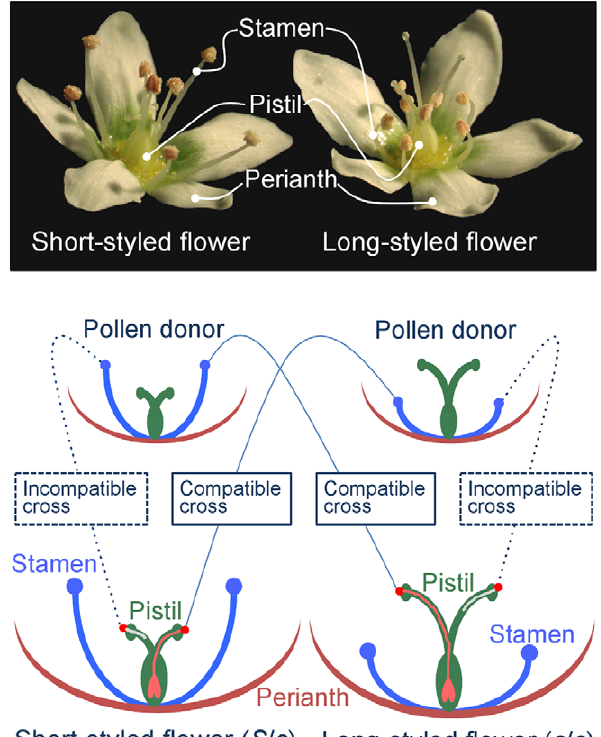
Figure 1. Dimorphic flowers of buckwheat and schematic presentation of the intra-morph incompatibility response in buckwheat. Short-styled flowers of buckwheat have long stamens and vice versa. A pollen grain from a long-styled plant germinates and the pollen tube successfully elongates to reach the ovary in the pistil of a short-styled plant, whereas it germinates but fails to elongate in the style of long-styled flower.